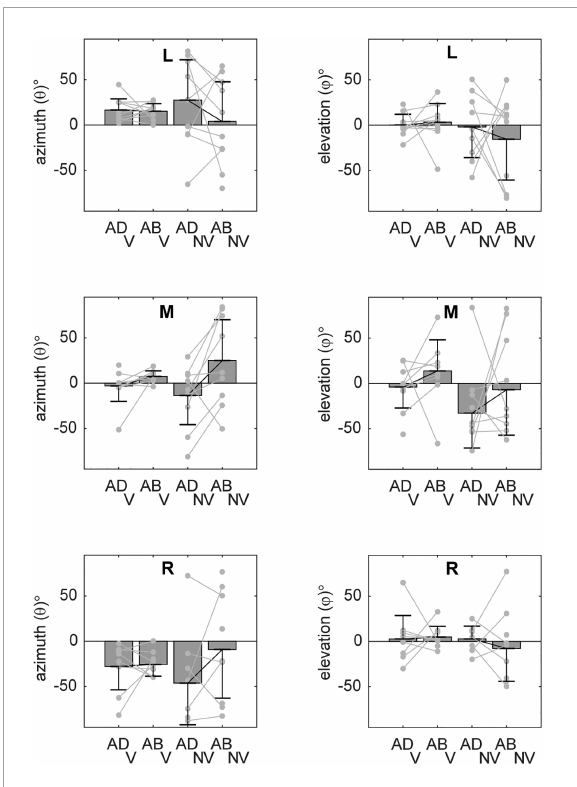
FIGURE8 Average orientations of the principal axes of variability ( ± circular SDs) for each target. Individual participant data are superimposed on each set of bars (light gray lines). Azimuth angles ( θ ) grossly followed changes in required movement direction. Elevation angles ( ϕ ) were more variable but were close to 0 ◦ in many cases, indicative of largely horizontal orientations. For the middle target (M), a change in arm posture from ADD to ABD was associated with increasing values of θ (particularly in the NV condition), consistent with a counterclockwise rotation in the horizontal plane (cf. Figure 5 ). in azimuth differences ( R 2 = 0.23), though the results of this regression analysis were not statistically significant ( F = 4.248;